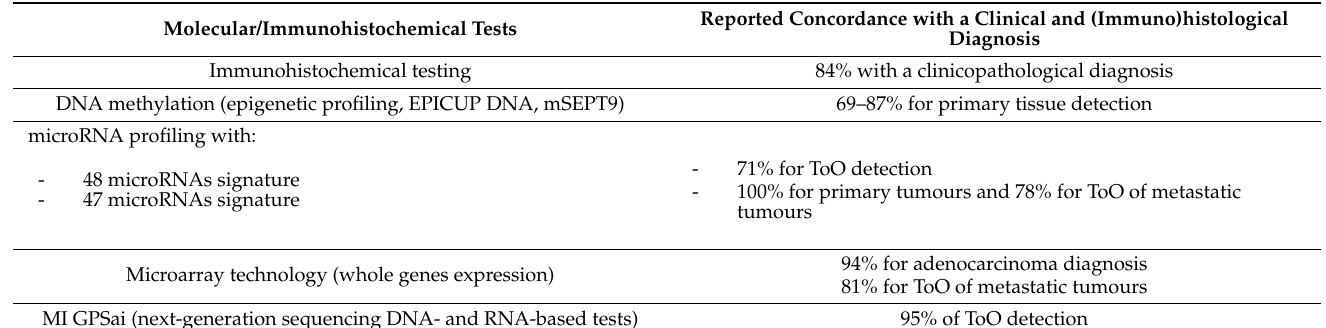
Table 1. Molecular assays used to identify the tissue of origin (ToO) in CUPs